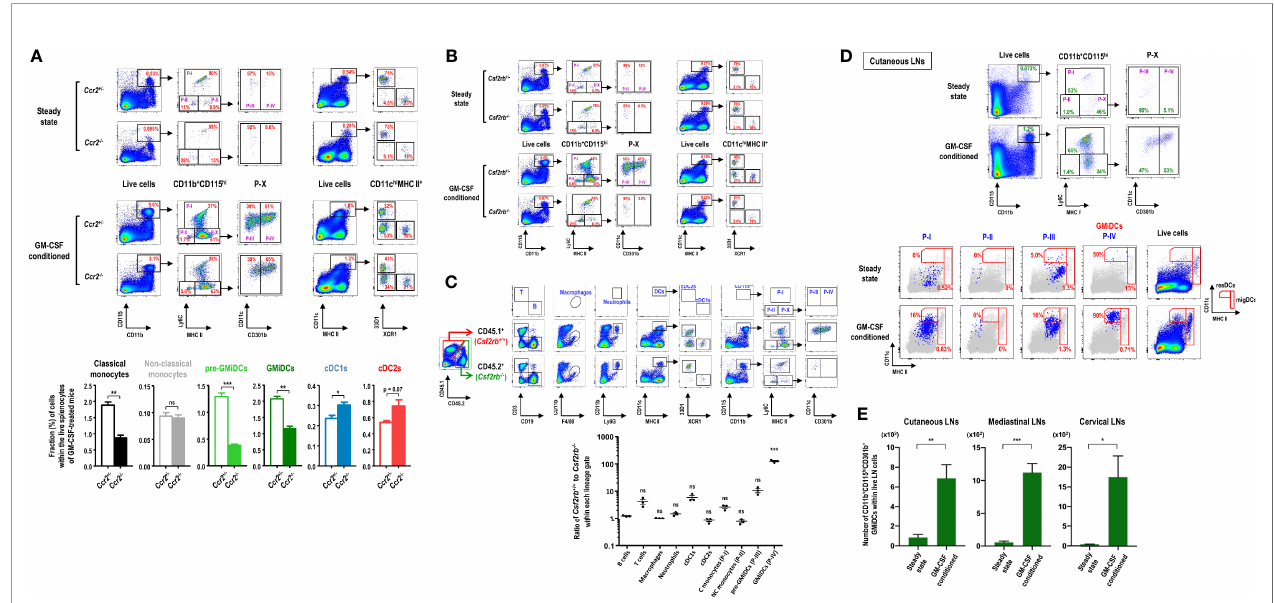
FIGURE 7 | Differentiation of GMiDCs from classical monocytes necessitates the cis expression of GM-CSF receptor. (A) Gating strategy (upper panels) and analysis (lower graphs) showing differences in the fractions of DC and CD11b + CD115 hi cell subsets in the spleen between Ccr2 +/- and Ccr2 -/- mice treated with or without GM-CSF. Data are shown in mean ± SEM (n = 3 for each genotype and condition). (B) Gating strategy showing differences in the fractions of DC and CD11b + CD115 hi cell subsets in the spleen between Csf2rb +/- and Csf2rb -/- mice treated with or without GM-CSF. Representative fl ow cytograms (n = 3 for each genotype and condition). (C) Gating strategy (upper panels) and the ratio of CD45.1 cells to CD45.2 cells (lower graph) of each Lin + population in GM-CSF- treated mixed BM chimeric mice at 6 weeks after adoptive transfer of Csf2rb +/+ (CD45.1) and Csf2rb -/- (CD45.2) BM at a 1:1 ratio into lethally irradiated WT (CD45.1) recipients. Data are shown in mean ± SEM (n = 3 mice) and compared to the mean of the B cells. (D) Gating strategy identifying CD11b + CD115 hi cell subsets in cutaneous LNs of control and GM-CSF-treated mice (upper). Each population (blue dots) of CD11b + CD115 hi cell subsets in the LNs is backgated in an MHC II versus CD11c dot plot of total live-gated cells (gray dots), indicating the fraction of each subset within the respective DC gates of resident (resDC) and migratory (migDC) phenotypes (lower). Representative fl ow cytograms (n = 4 mice for each condition). (E) Graphs showing the number of CD11b + CD115 hi CD301b + GMiDCs cells in the respective LNs of control and GM-CSF-treated mice according to the gating strategies as in (D) and Supplementary Figure 35 . Data are shown in mean ± SEM (n = 4 mice for each condition). *p ≤ 0.05; **p ≤ 0.01; ***p ≤ 0.001; ns, not signi fi cant; Student ’ s t -test (A, E) ; one-way ANOVA test (C)